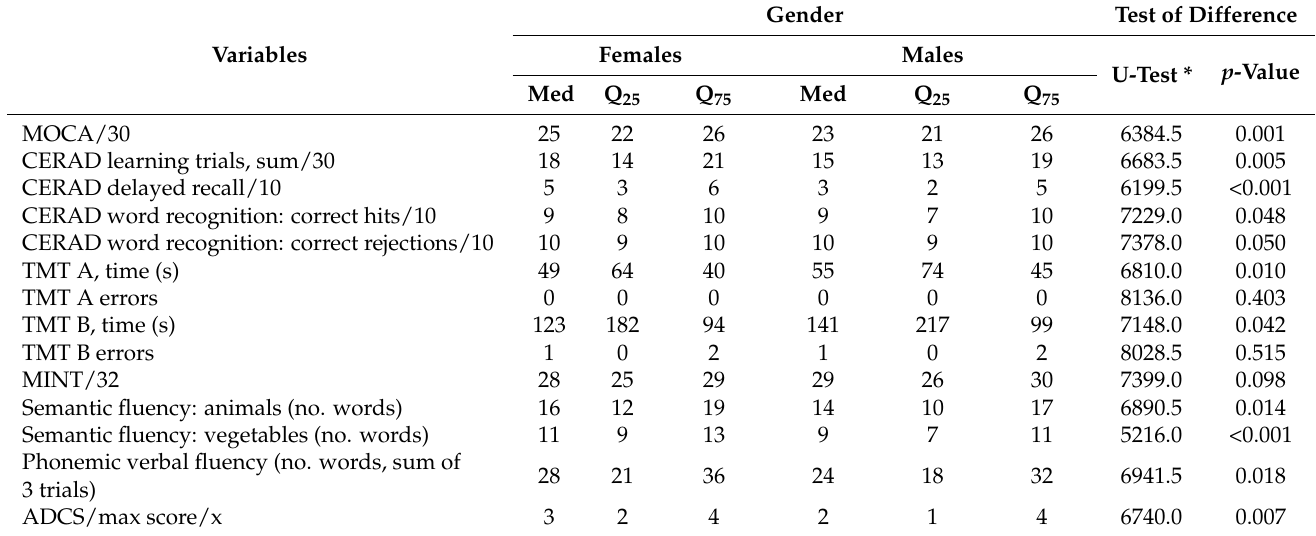
Table 3. Summary statistics for neuropsychological test scores for gender groups.